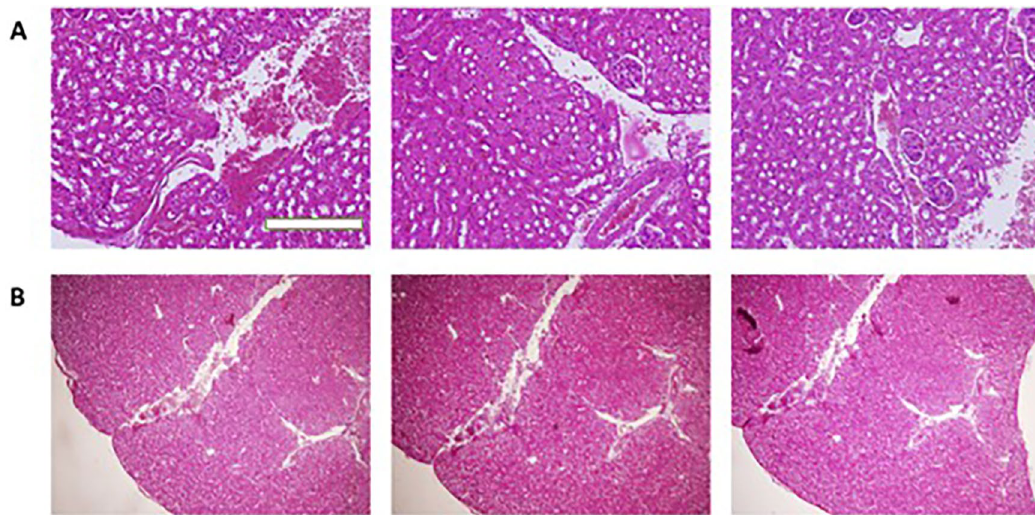
Figure 8. The histopathological analysis of kidney tissue upon application of DOX-loaded nanostructures. The morphology of cells in tissue has not changed and no vessel occlusion is observed, showing high biocompatibility of nanoparticles ( A,B ). The used concentration of the nanoparticles: 17.5 μg/mL. The scale bar is 50